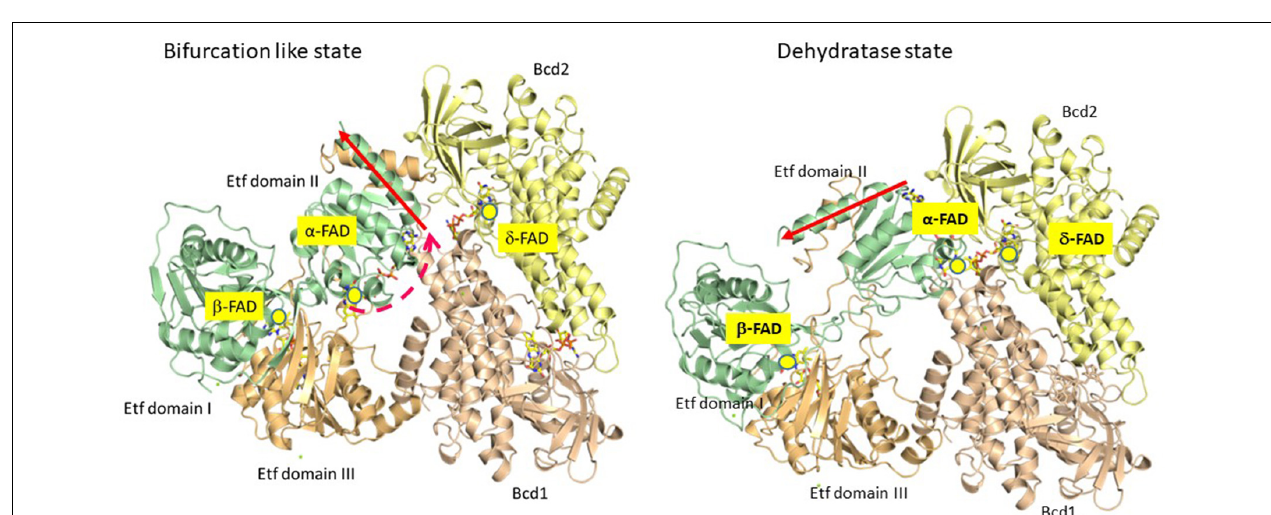
FIGURE 1 | An example of energy conservation in butyrate producing anaerobic bacteria via the generation of an ion motif force. The bifurcating EtfAB-Bcd complex reduces 2 Fd with NADH driven by the exergonic reduction of crotonyl-CoA to butyryl-CoA with a second NADH. The Rnf complex in the membrane produces 2 (cid:49) µ Na + from the exergonic reduction of NAD + by 2 Fd − . The ATPase generates 1 ATP from 4 (cid:49) µ Na + .